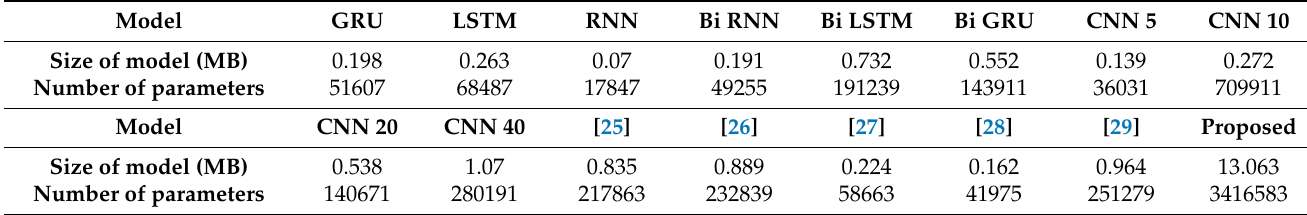
Table A2. Computational cost of each